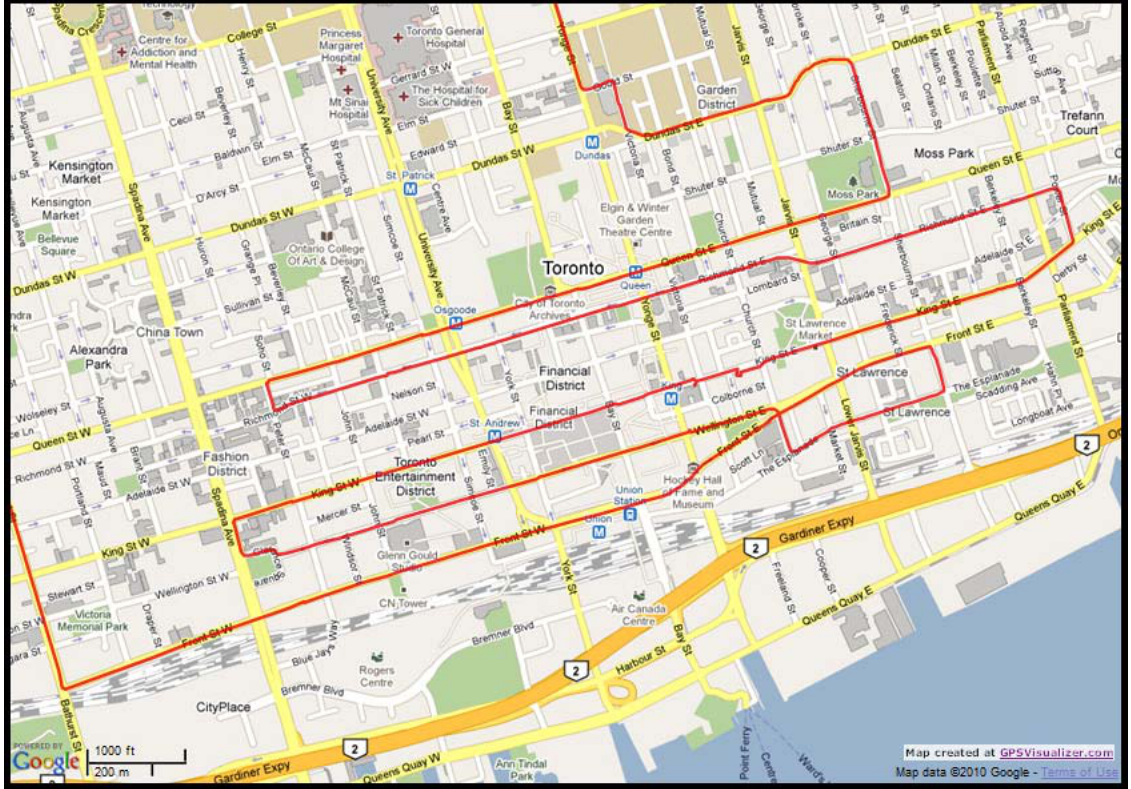
Figure 18. Zoom in on the downtown portion of Toronto trajectory.